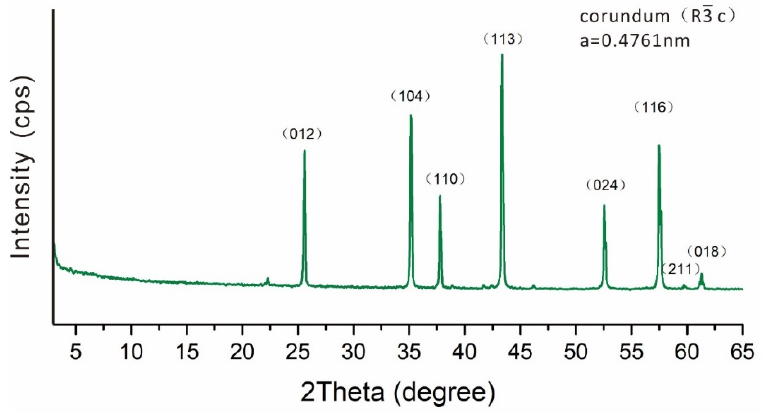
Figure 3. XRD patterns of the specimen.